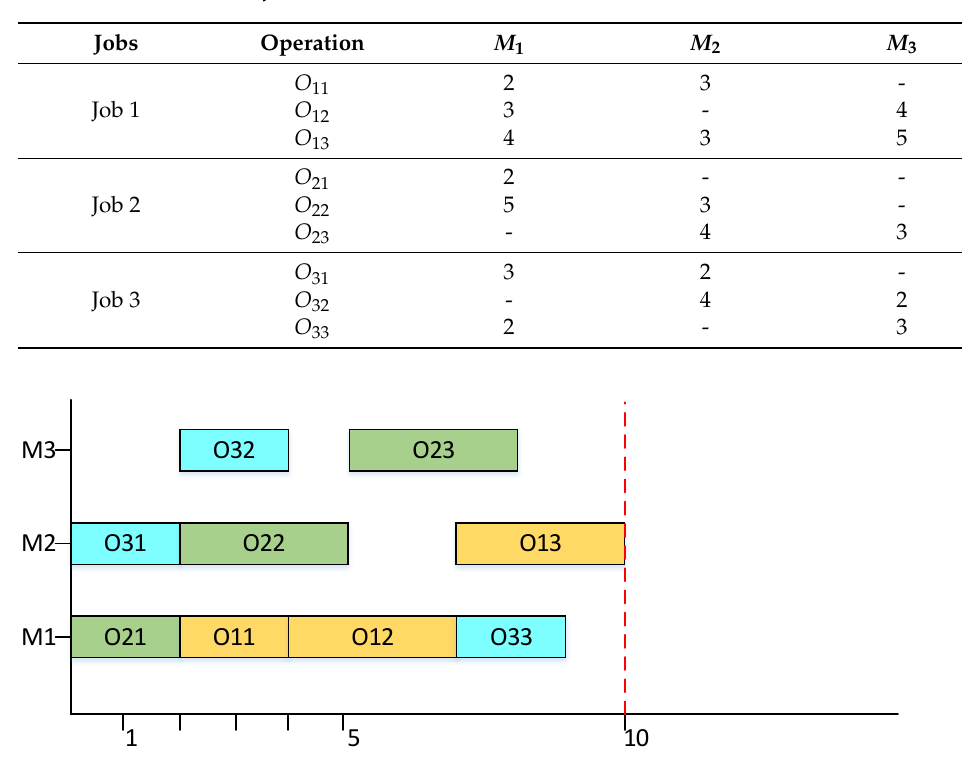
Table 3. An instance of FJSP with a scale of 3 × 3.